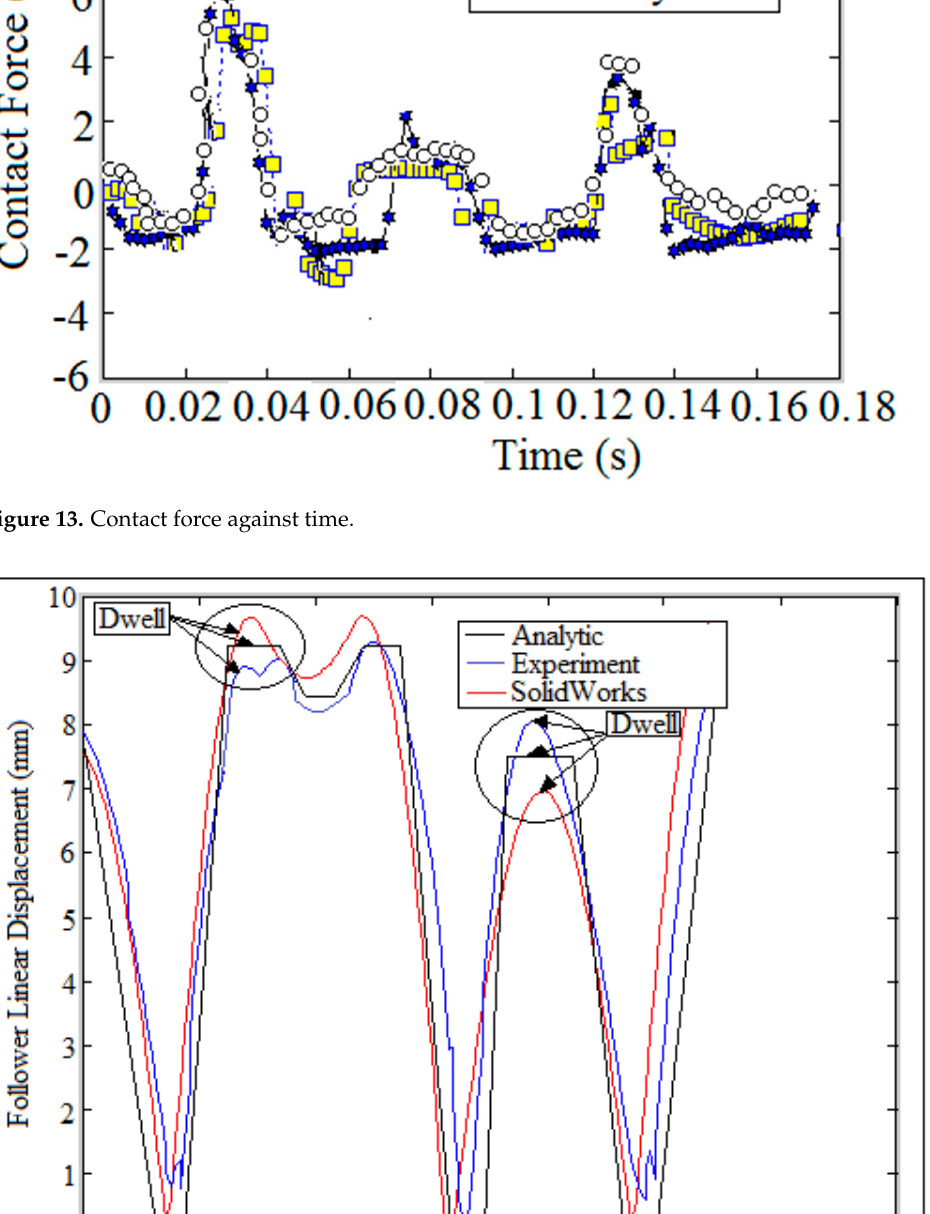
Figure 14. Comparison of follower displacement.